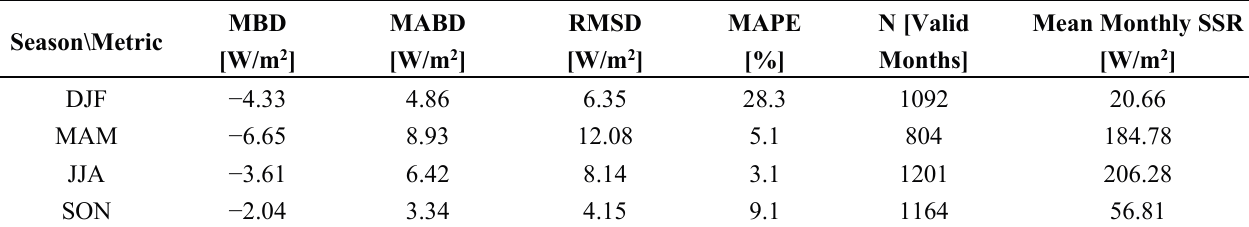
Table 5. Compiled seasonal validation metrics for SARAH monthly means (1983–2013) from the valid 15 sites. Mean monthly SSR is from in situ observations with valid matching SARAH retrievals, including snow